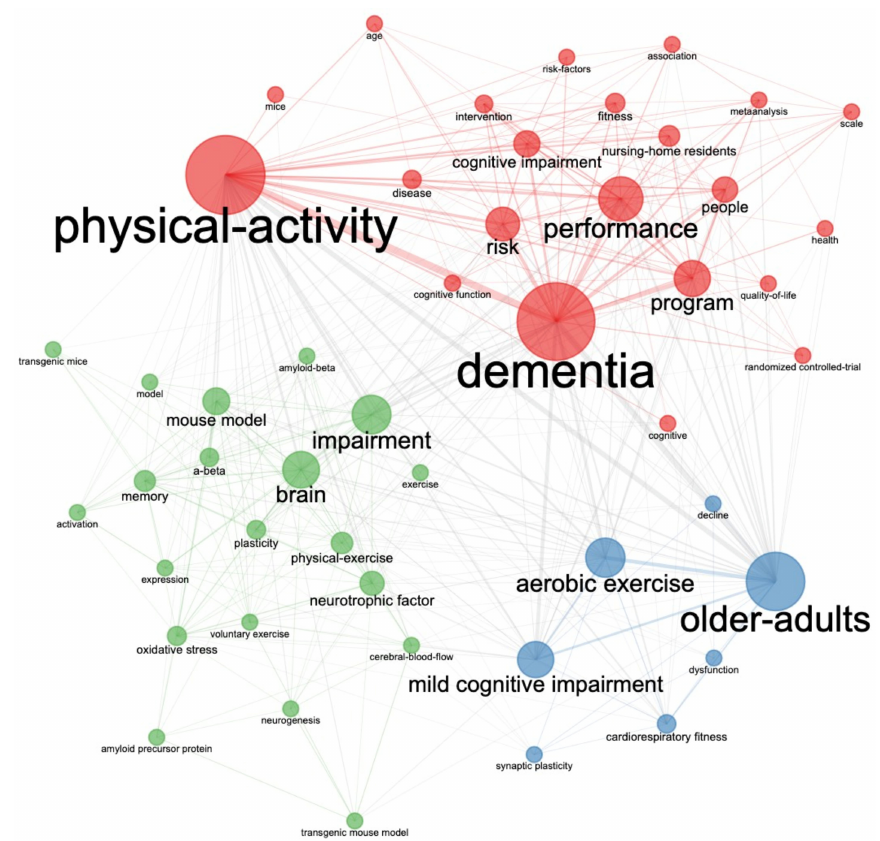
Figure 10. The keyword plus co-occurrence network in AD exercise